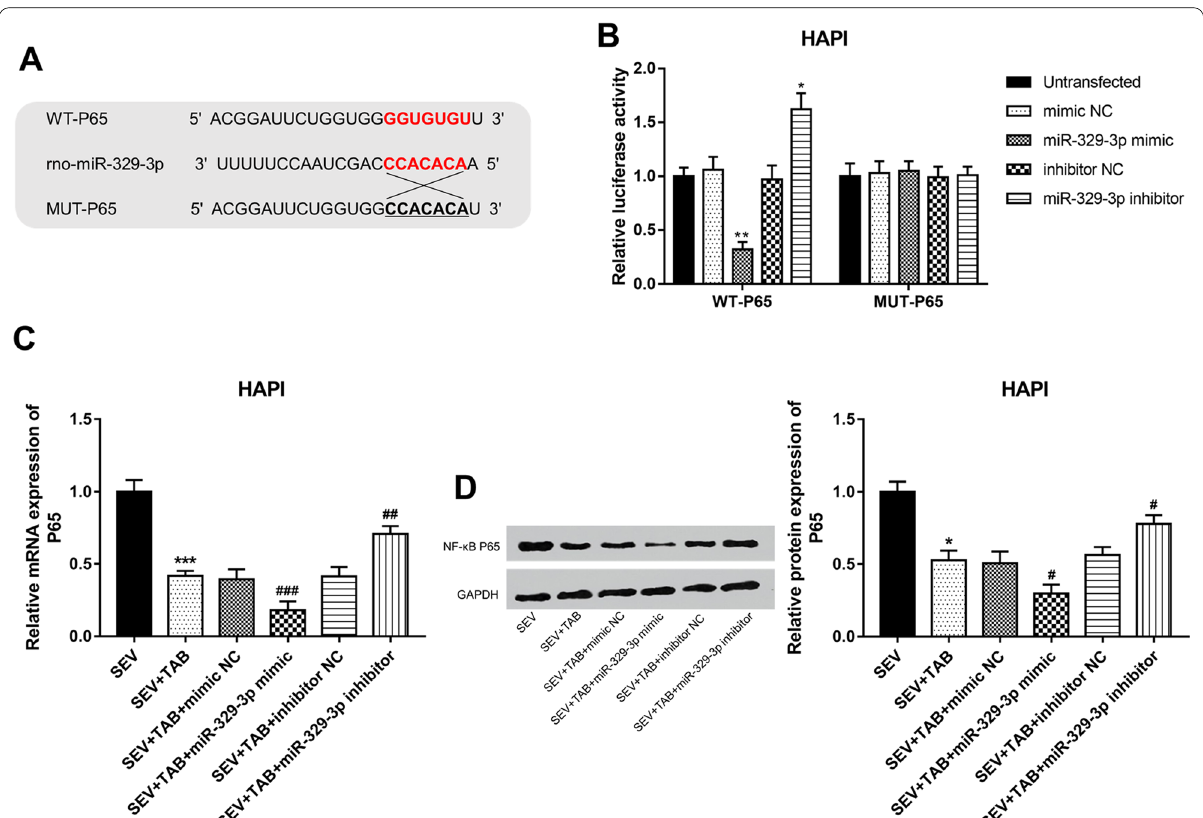
Fig. 7 miR-329-3p directly targeted NF-κB P65 and inhibitedthe NF-κB pathway in HAPI cells. A The complementary sequence of miR-329-3p atthe 3’-UTR of NF-κB P65. B miR-329-3p significantly inhibited the relativeluciferase activity in HAPI cells with WT- NF-κB P65 (* P < 0.05). C NF-κB P65 mRNA expression was suppressed by TAB inHAPI cells exposed to sevoflurane, and this effect was further enhanced bymiR-329-3p mimic, but was weakened by miR-329-3p reduction (*** P < 0.05 compared to SEV; ## P <0.01, ### P < 0.001 compared to SEV TAB). D miR-329-3p overexpression + significantly inhibited the protein expression ofNF-κB P65, while miR-329-3p reduction led to the opposite effects on NF-κB P65protein expression (* P < 0.05compared to SEV; # P <0.05compared to SEV +